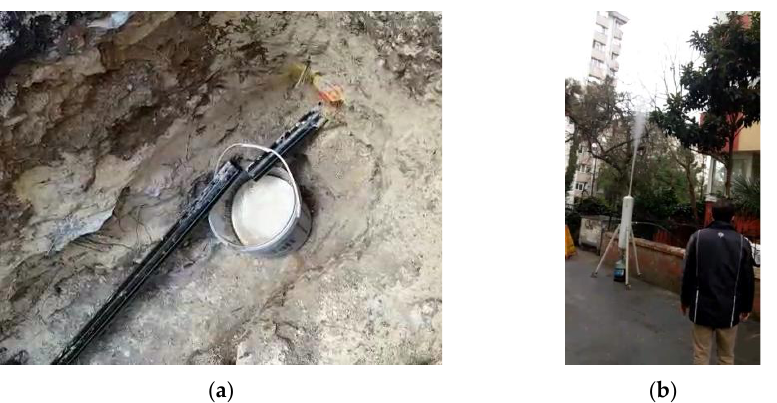
Figure 2. Natural gas liquid drop-out for polyethylene pipelines; ( a ) Liquid drop-out from PE pipes; ( b ) Two-phase mixture by discharging PE pipeline.